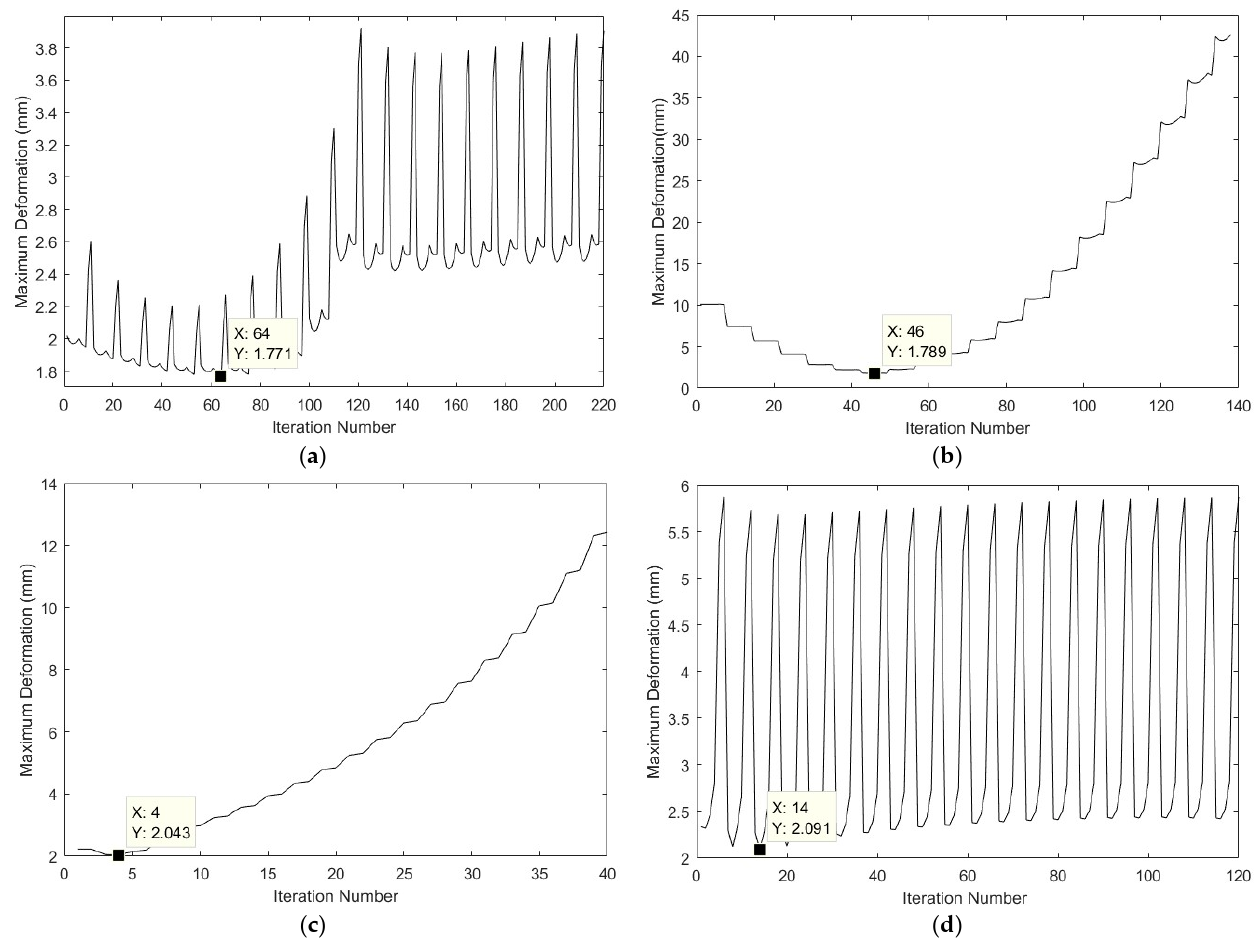
Figure 10. ( a ) Subcase 1: graph of maximum deformation, ( b ) Subcase 2: graph of maximum deformation, ( c ) Subcase 3: graph of maximum deformation, ( d ) Subcase 4: graph of maximum deformation.